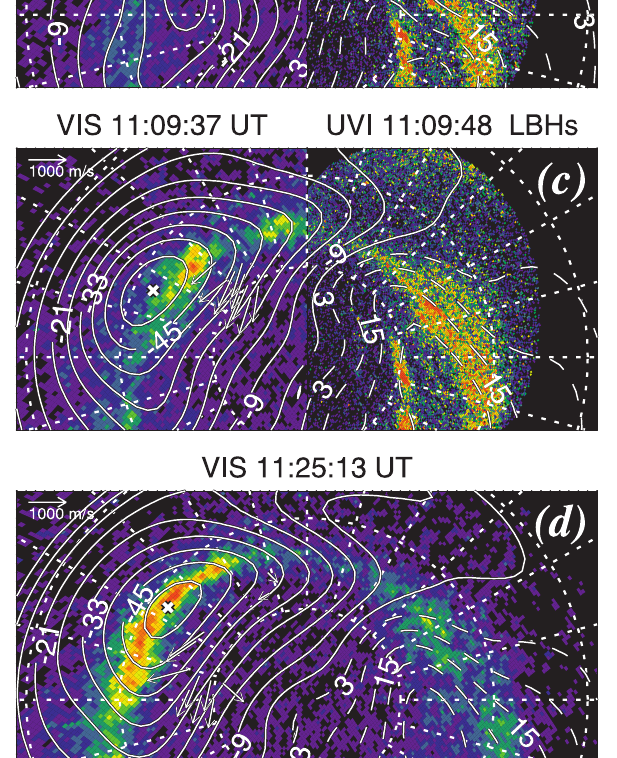
Fig. 5. The dayside utraviolet aurora measured by the VIS Earth Camera and UVI and the spherical harmonic expansion of the iono- spheric equipotential contours deduced from the map potential tech- nique (Ruohoniemi and Baker, 1998). (a) The ionospheric condi- tions prior to reconnection as seen in the 10:57:25 UT VIS scan of the postnoon aurora, the 10:57:32 UT UVI scan of the prenoon au- rora, and the map potential contours from the 10:57–10:58 UT Su- perDARN radar scans. (b) The ionospheric conditions just follow- ing the onset of reconnection as seen in the 11:06:01 UT VIS scan of the postnoon aurora, the 11:06:44 UT UVI scan of the prenoon aurora, and the map potential contours from the 11:06–11:07 UT SuperDARN radar scans. (c) The ionospheric conditions just at the onset of the second burst of reconnection as seen in the 11:09:37 UT VIS scan of the postnoon aurora, the 11:09:48 UT UVI scan of the prenoon aurora, and the map potential contours from the 11:09– 11:10 UT SuperDARN radar scans. (d) The ionospheric conditions as the remnants of the first reconnected flux region convect out of the CUTLASS fields of view as seen in the 11:25:13 UT VIS scan of the dayside aurora, and the map potential contours from the 11:25– 11:26 UT SuperDARN radar